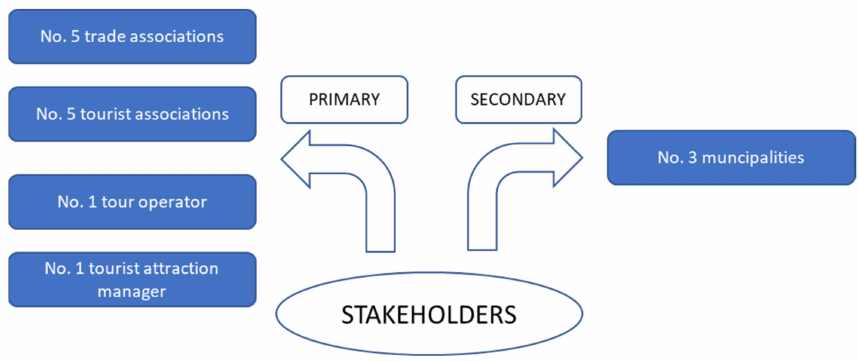
Figure 2. Primary and secondary stakeholders involved in the research activities.